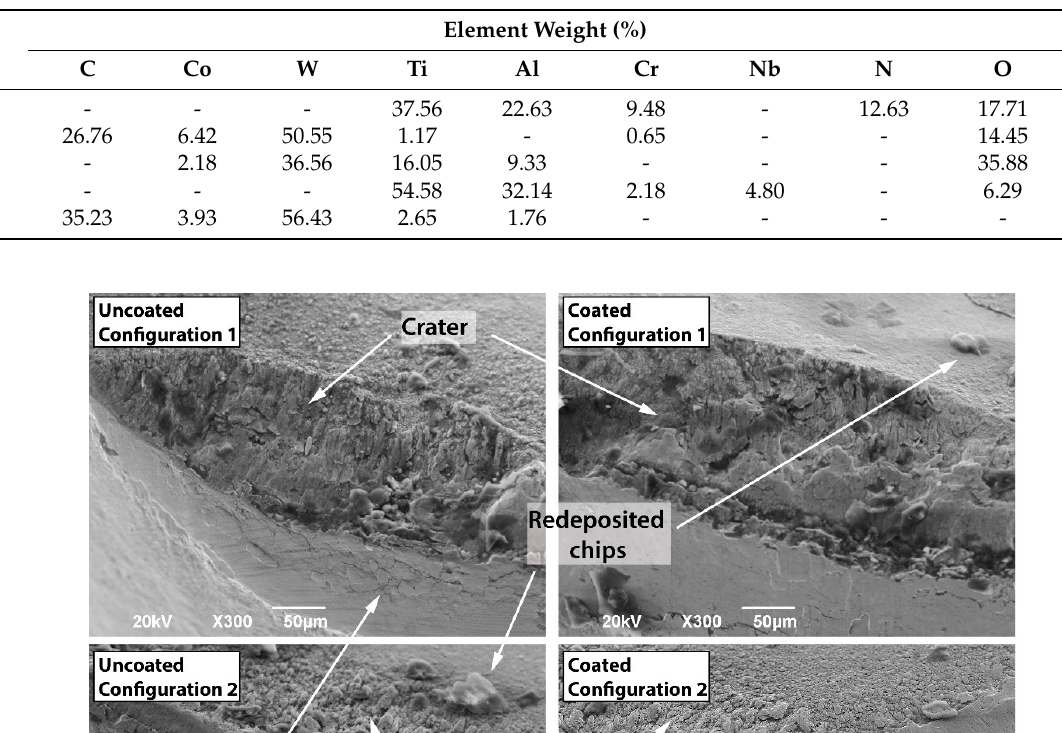
Table 4. Chemical composition of each zone determined by EDS analysis.